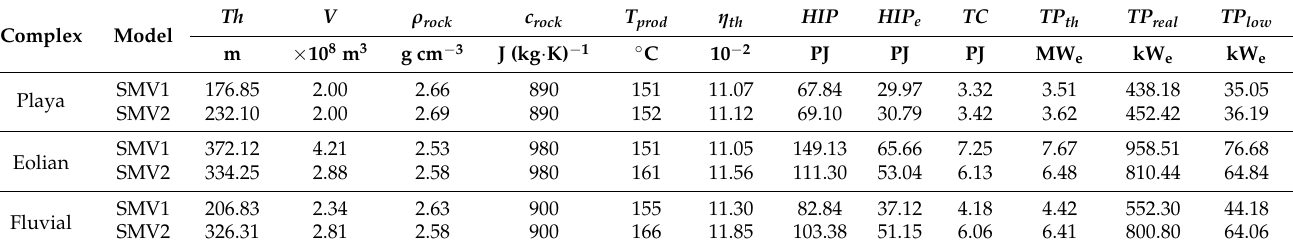
Table 6. Geothermal parameters of Rotliegend complexes in Kłecko Anticline for EGS system based on a 3D modeling and literature review, combined with the results of preliminary potential